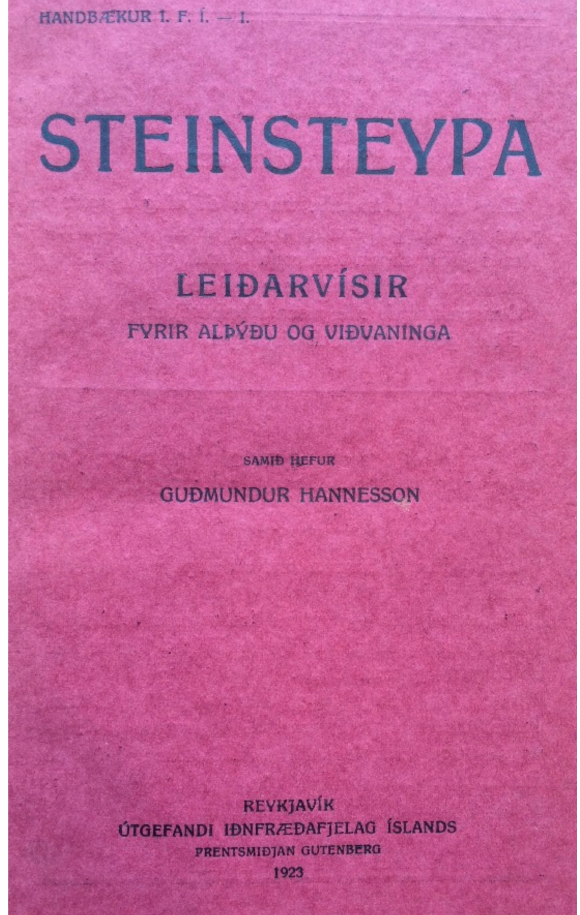
Figure 6. Guðmundur Hannesson, Steinsteypa : Leiðarv í sir fyrir alþ ý ðu og viðvaninga , 1921. Book cover. Copy available at the Reykjav í k City